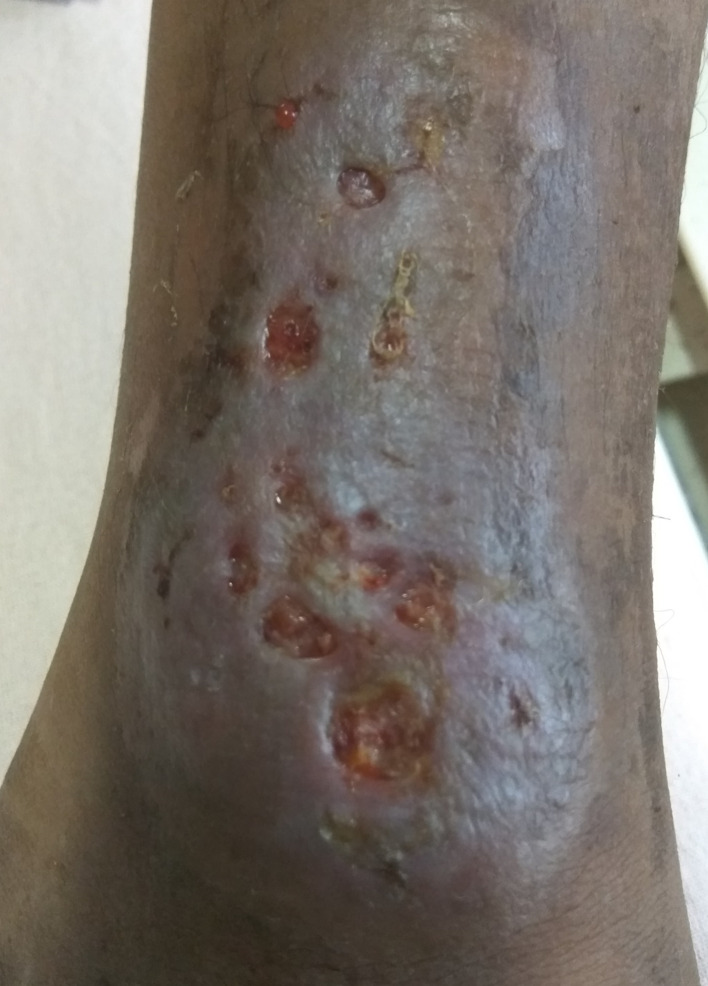
Clinical photograph of ulcerative skin lesion of a patient with X-linked agammaglobulinemia (XLA) suspected to be related to Helicobacter sp. infection.